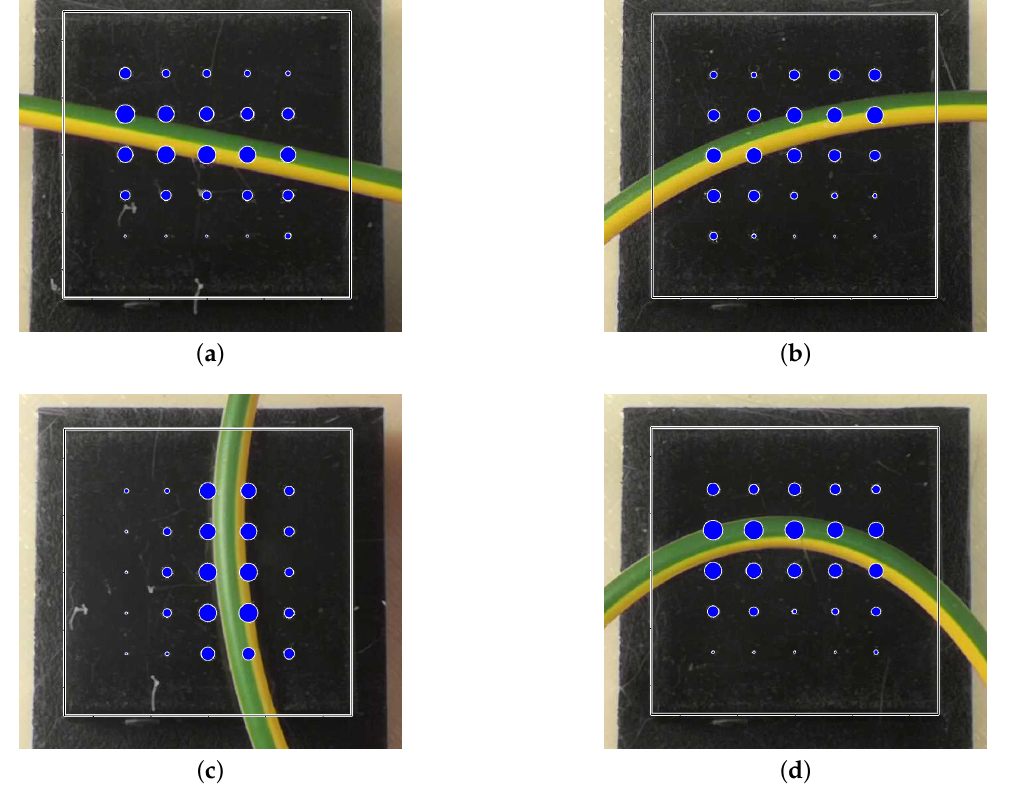
Figure 19. Examples of tactile maps during the grasp of a cable: linear horizontal case ( a ), quadratic horizontal case ( b ), quadratic vertical case ( c ) and high curvature case ( d